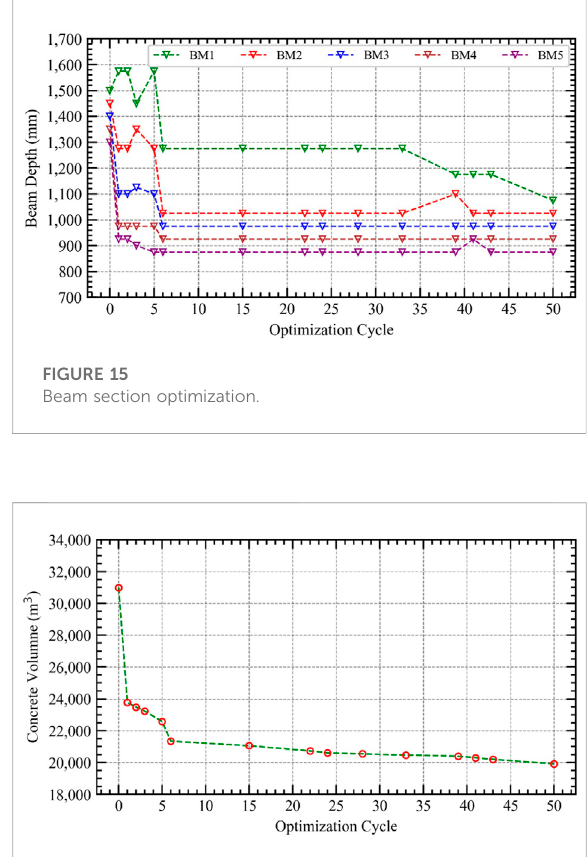
FIGURE 16 Structural concrete volume optimization.